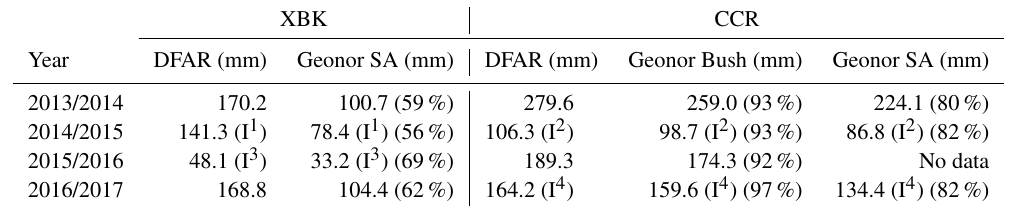
Table 2. Seasonal totals of precipitation (October through April, where available) and the relative catch (%) for the Geonor SA and Geonor bush compared to the DFAR. Incomplete seasonal totals (I) are usually due to precipitation data starting later than 1 October (see footnotes).